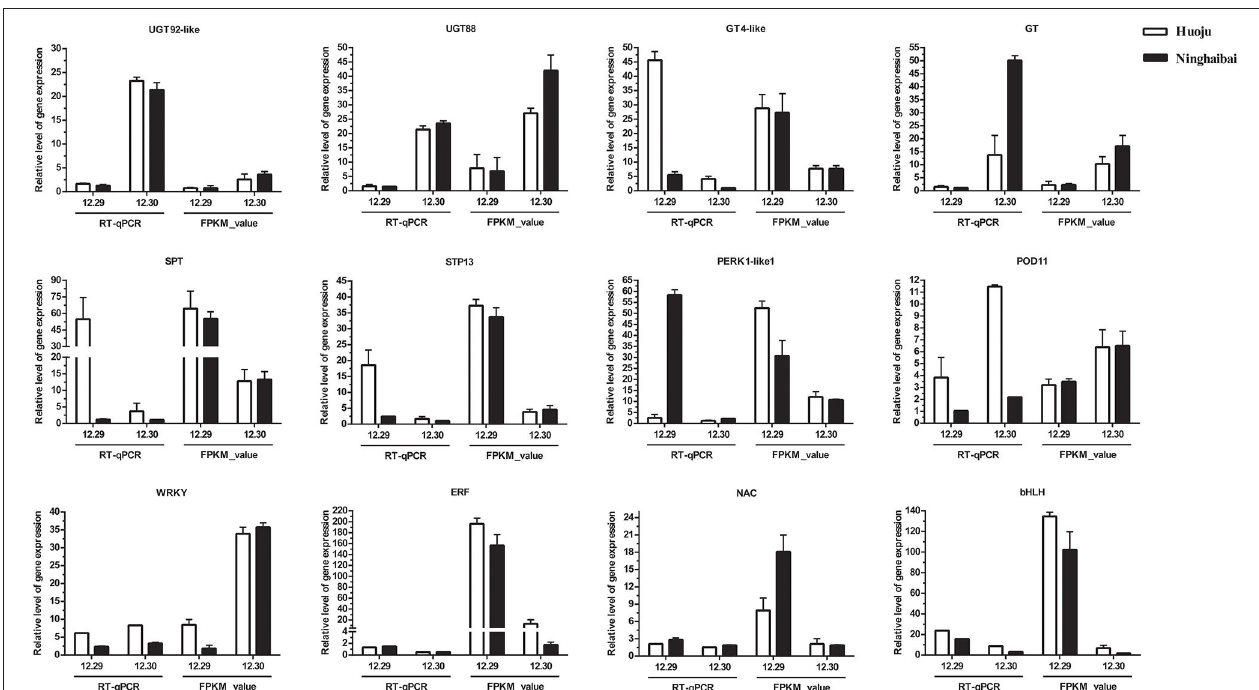
FIGURE 9 | Quantitative RT-PCR validation of differential gene expression under cold stress, the transcript level of DEGs and DETFs from RT-qPCR and RNA-seq at sampling dates (12.29 and 12.30). Error bars represent the standard deviation based on three